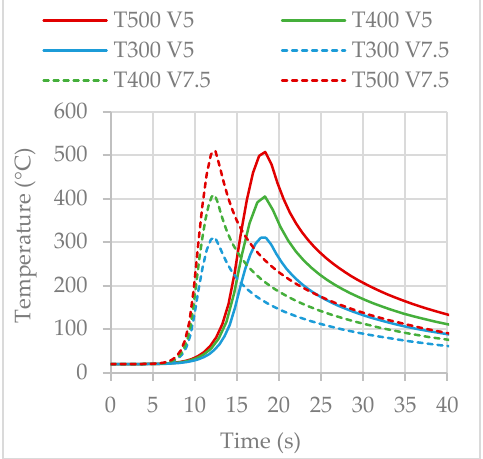
Figure 8. Investigated laser thermal cycles.